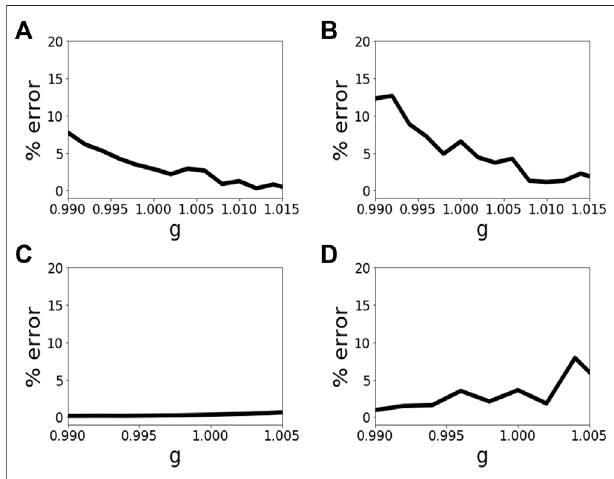
Frontiers in Physics |